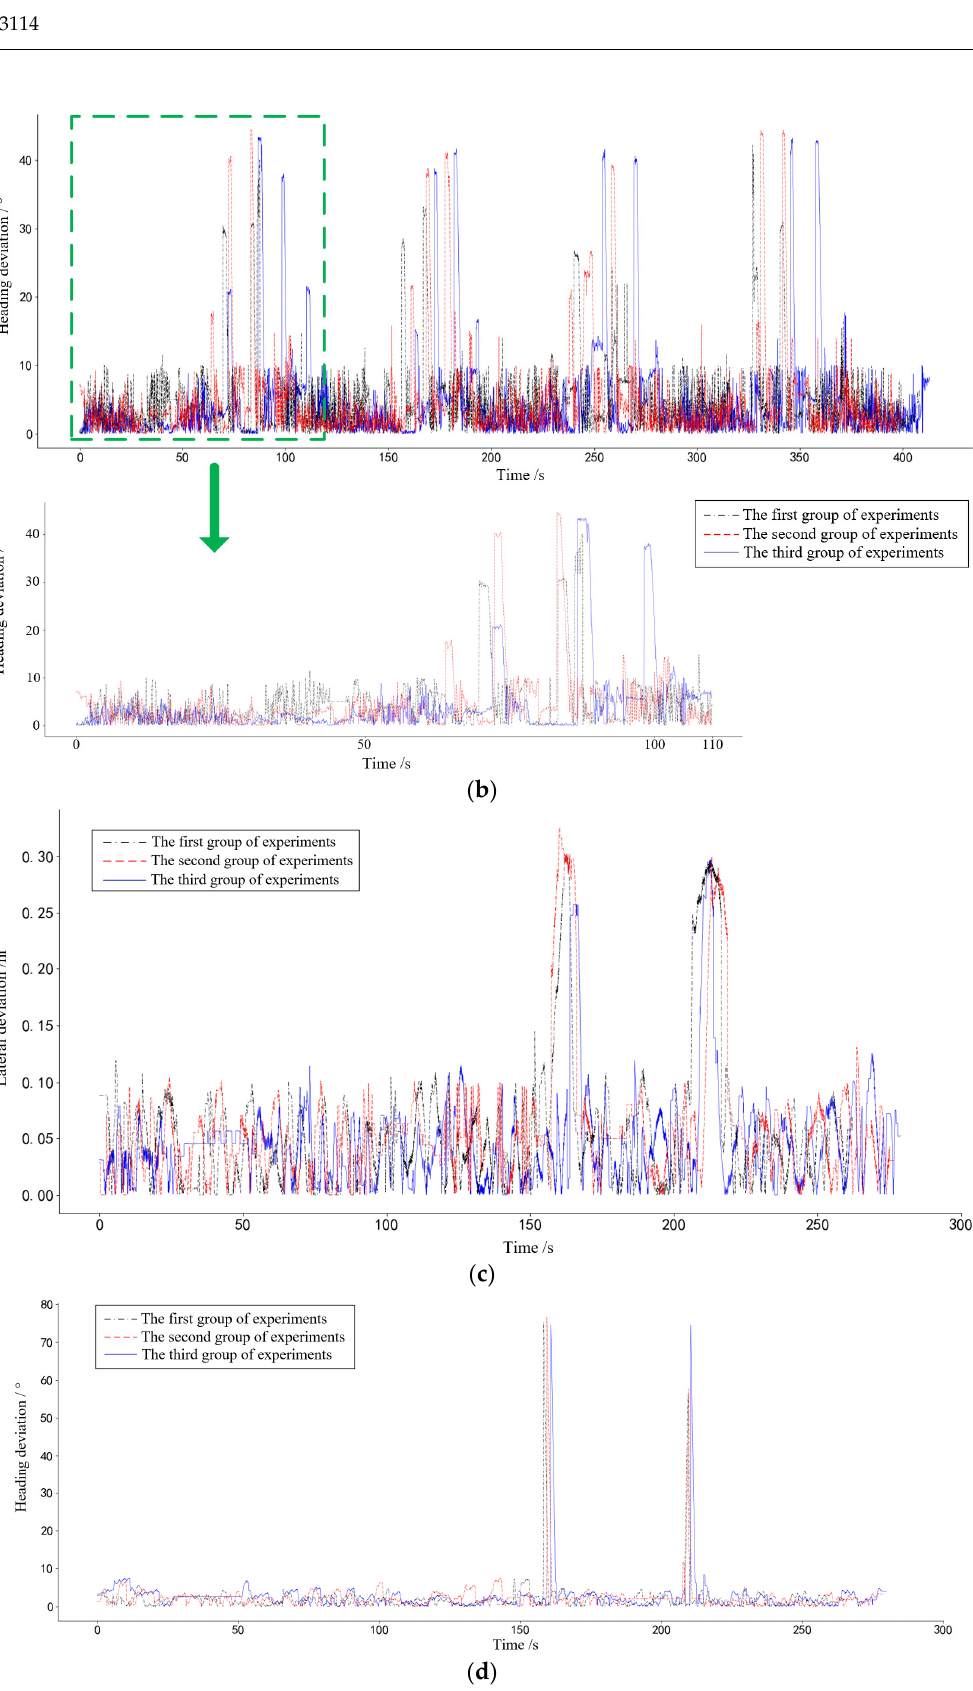
Figure 21. Results of cooperative navigation control experiments with spraying–dosing robot group. ( a ) Lateral error of spraying robot; ( b ) heading error of spraying robot; ( c ) lateral error of dosing robot; ( d ) heading error of dosing robot.